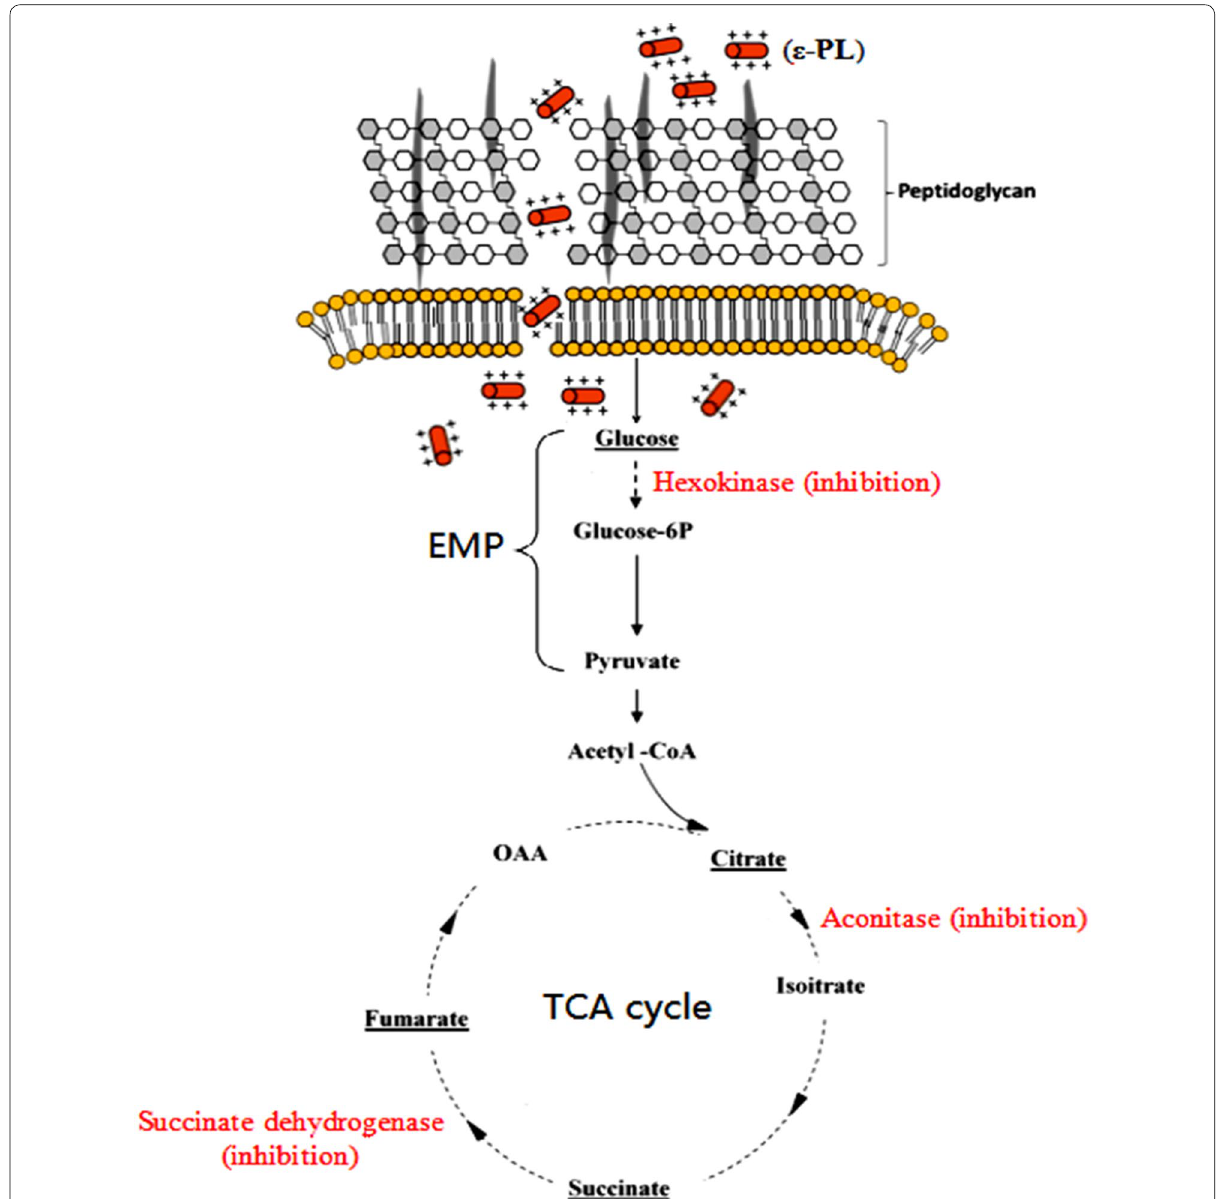
Fig. 5 Schematic illustration of ε-PL’s proposed mechanism of action on S.